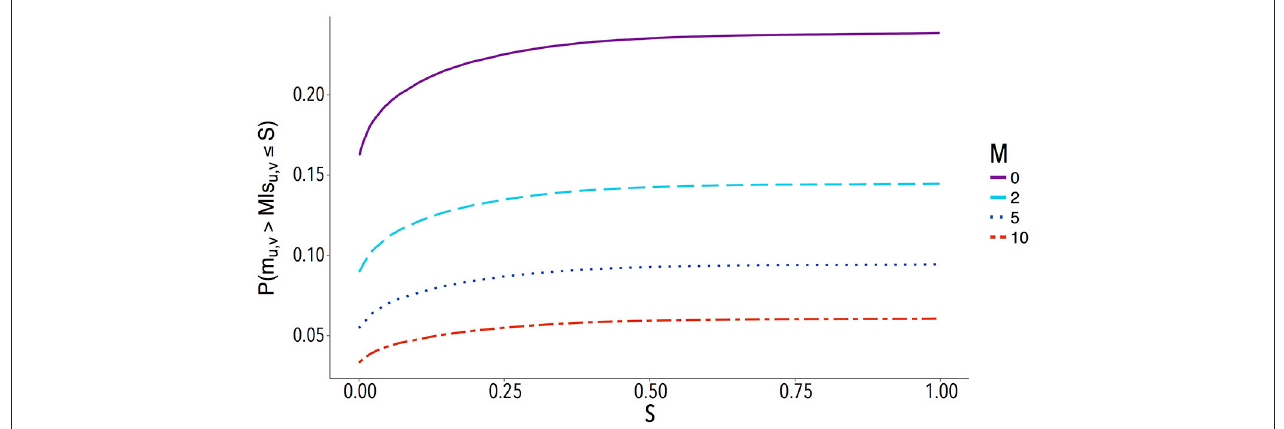
same for larger values of M , there is only a shift in the